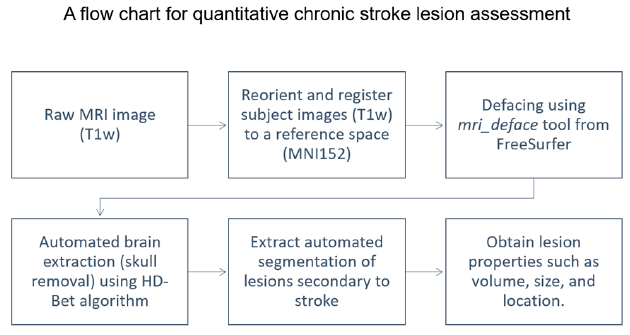
Figure 8. Flow chart detailing the quantitative chronic stroke lesion